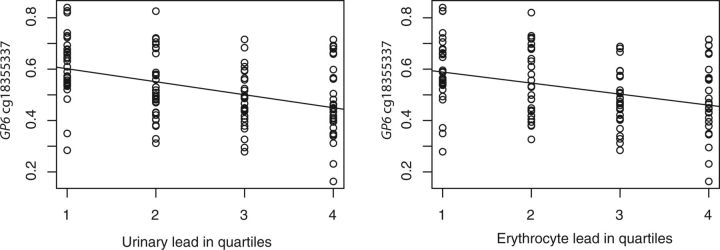
concentrations of lead in urine and in erythrocytes (both divided into quartiles) is
inversely associated with cord blood methylation (showed as Beta-values) of the CpG
site cg18355337 in GP6